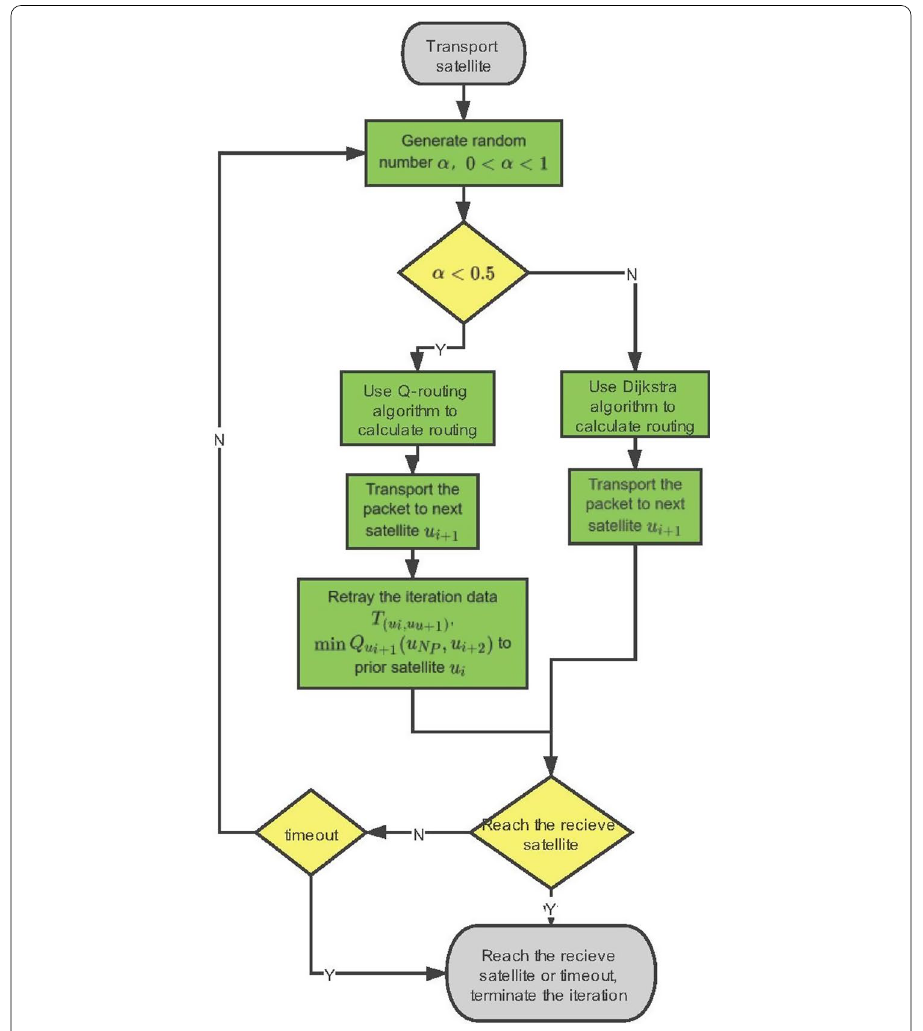
Fig. 6 The modified Q-routing algorithm